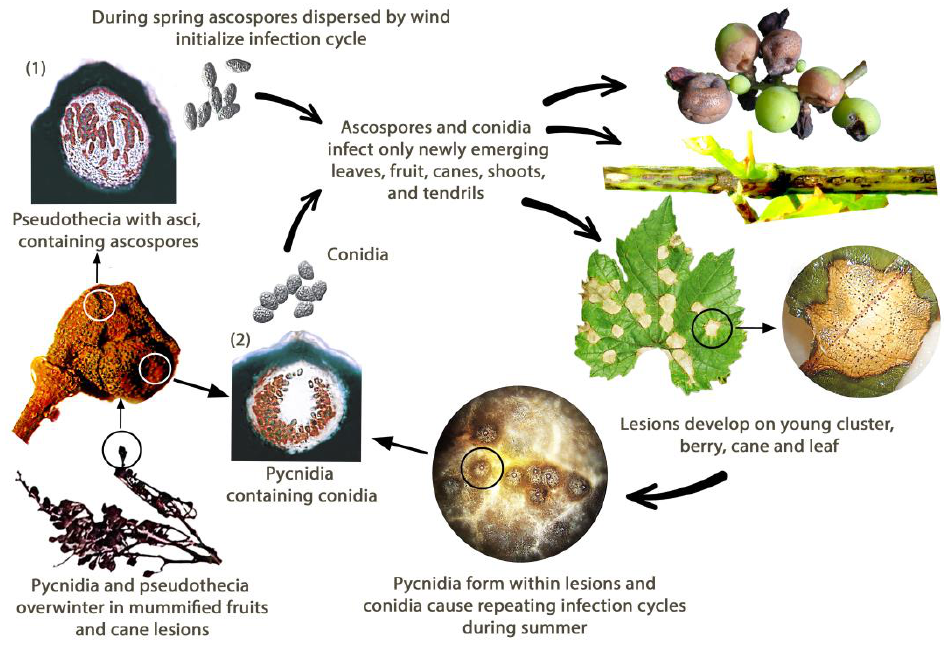
Figure 1. Disease cycle of black rot of grapes (1) (2)